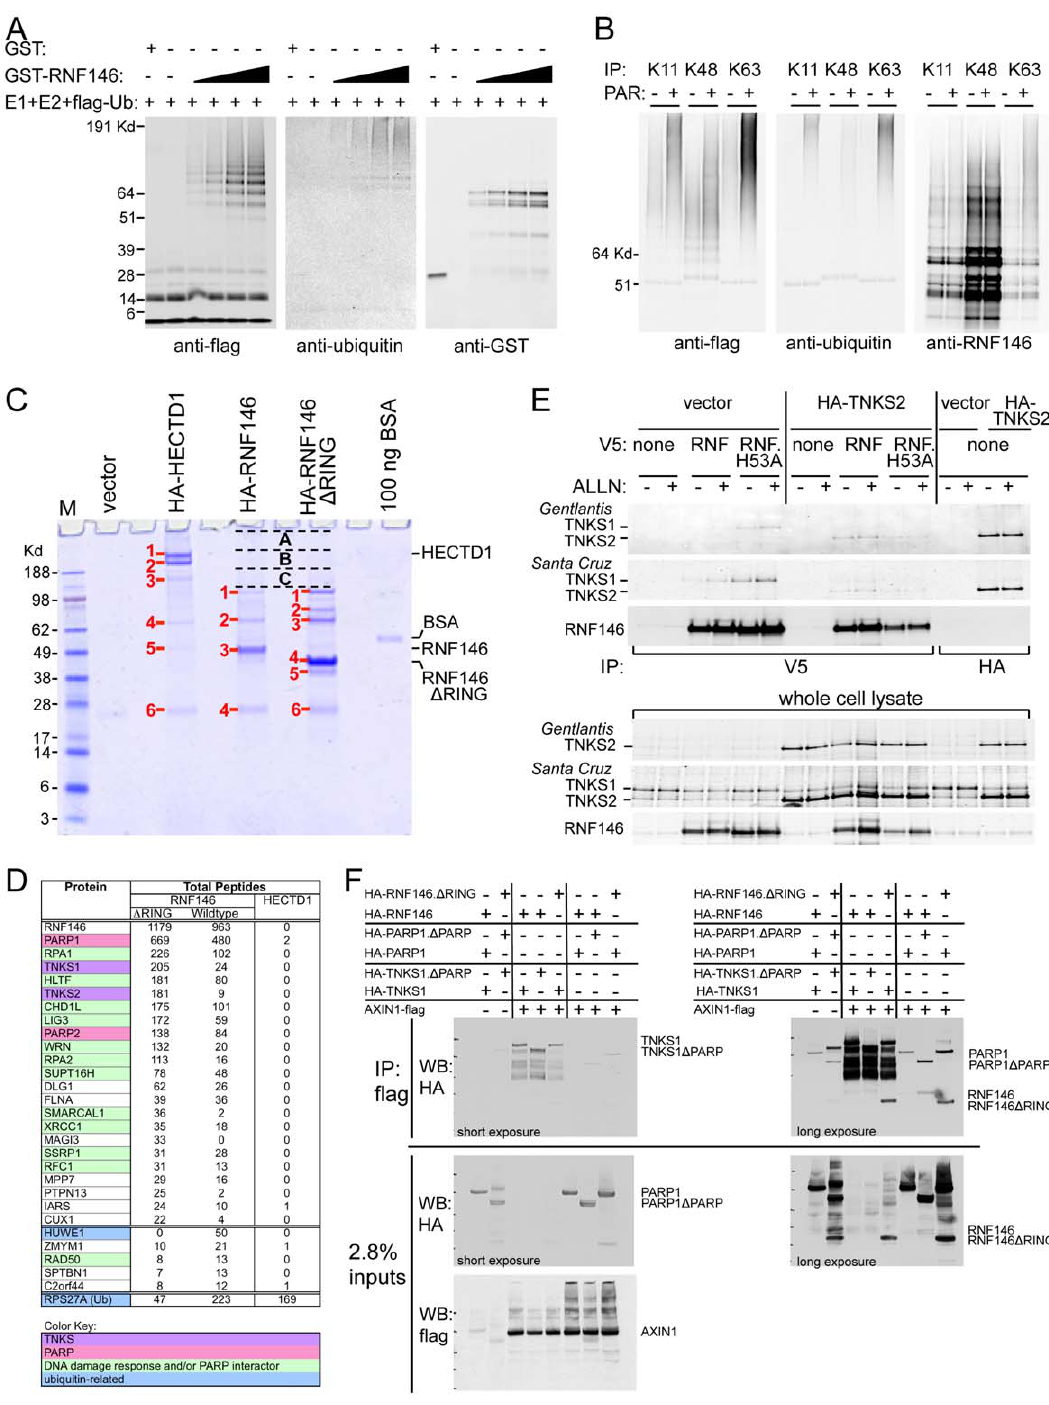
Figure 5. RNF146 displays ubiquitin E3 ligase activity invitro and binds to tankyrase, PARP1, and Axin proteins. (A) Western analysis of auto-ubiquitylation reactions with variable amounts of GST-RNF146 protein (see Materials and Methods) immunoblotted for flag-ubiquitin, polyubiquitin, or GST. GST protein serves as a negative control. (B) Western analysis as in (A) for GST-RNF146 ubiquitylation reactions incubated in the absence ( 2 ) or presence ( + ) of poly(ADP-ribose) [PAR] and immunoprecipitated with antibodies specific for K11-, K48-, or K63-linked polyubiquitin. Immunoblotting with RNF146 antibody serves as a loading control. Note that the K48 linkage-specific antibody more efficiently immunoprecipitates ubiquitylated RNF146, although the polyubiquitin chains are shorter in length and therefore less readily detected by anti-flag or -ubiquitin immunoblotting. (C) Coomassie-stained gel of anti-HA immunoprecipitates from cells transfected with the indicated expression constructs for RNF146 or control E3 ligase HECTD1. Numbered protein bands and lettered high-molecular-weight bands were excised for mass spectrometric analysis. (D) Table of proteins identified from the mass spectrometric analysis showing total numbers of peptides identified for each protein, combined for all numbered protein bands in (C). Shown are 23 proteins with the highest number of total peptides identified by interaction with RNF146 D RING protein, and with fewer than three peptides in the spectrometric analysis of HECTD1 protein interactors. The second set of 5 proteins